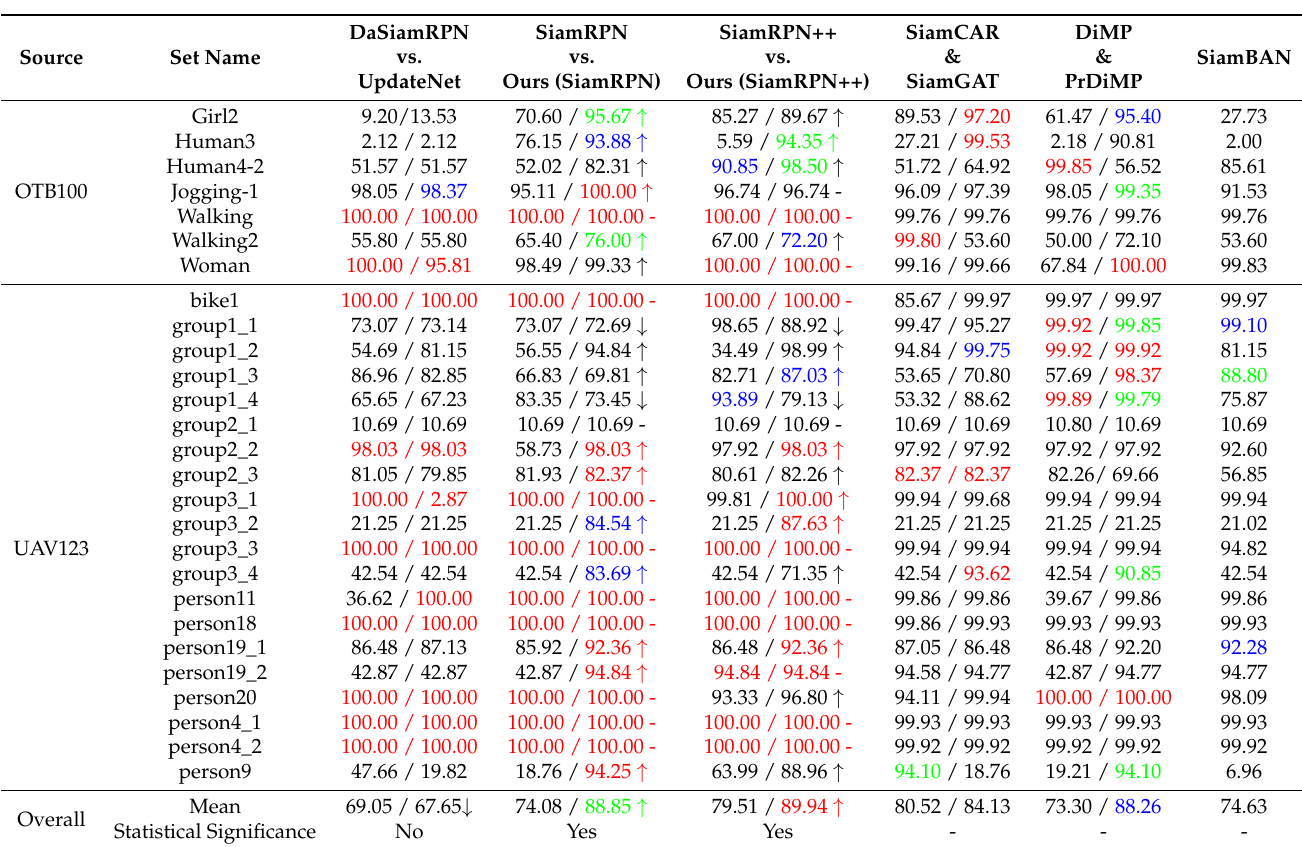
Table 3. The tracking robustness on public datasets. The uparrow and downarrow indicate the relative improvement. The red, green, and blue denote the methods that ranked first, second, and third in the experimental results. DaSiamRPN Source Set Name